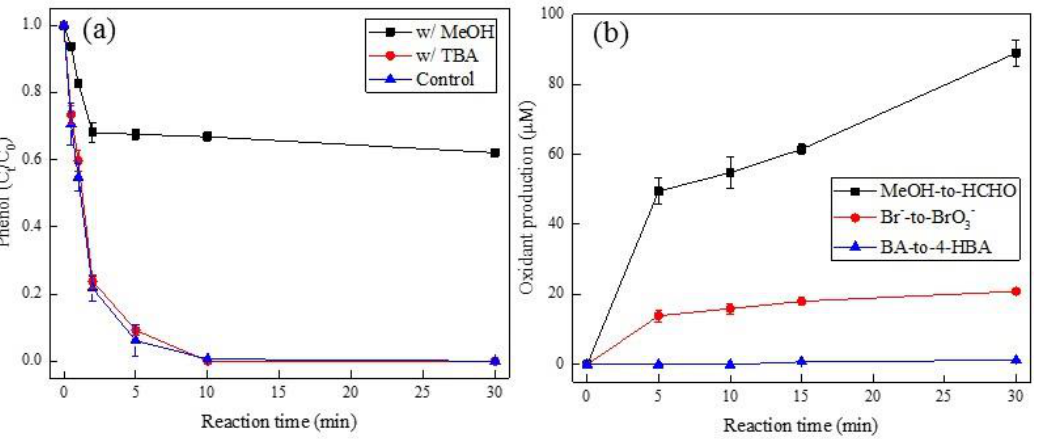
Figure 2. ( a ) The effect of MeOH and TBA on the degradation of phenol, and ( b ) oxidant production of HCHO, bromate, and 4-HBA in Pd(II)/PMS system. Condition: ( a ). [phenol] = 50 µM, [PMS]